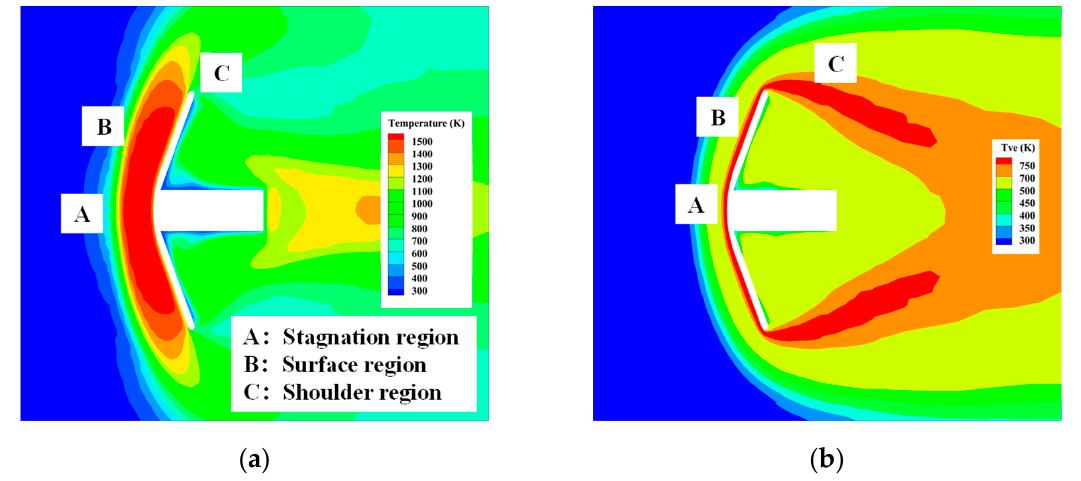
Figure 7. Temperature contours of the initial shape simulation; ( a ) translational rotation tempera- ture ( T tr ); ( b ) vibratory electron temperature ( T ve